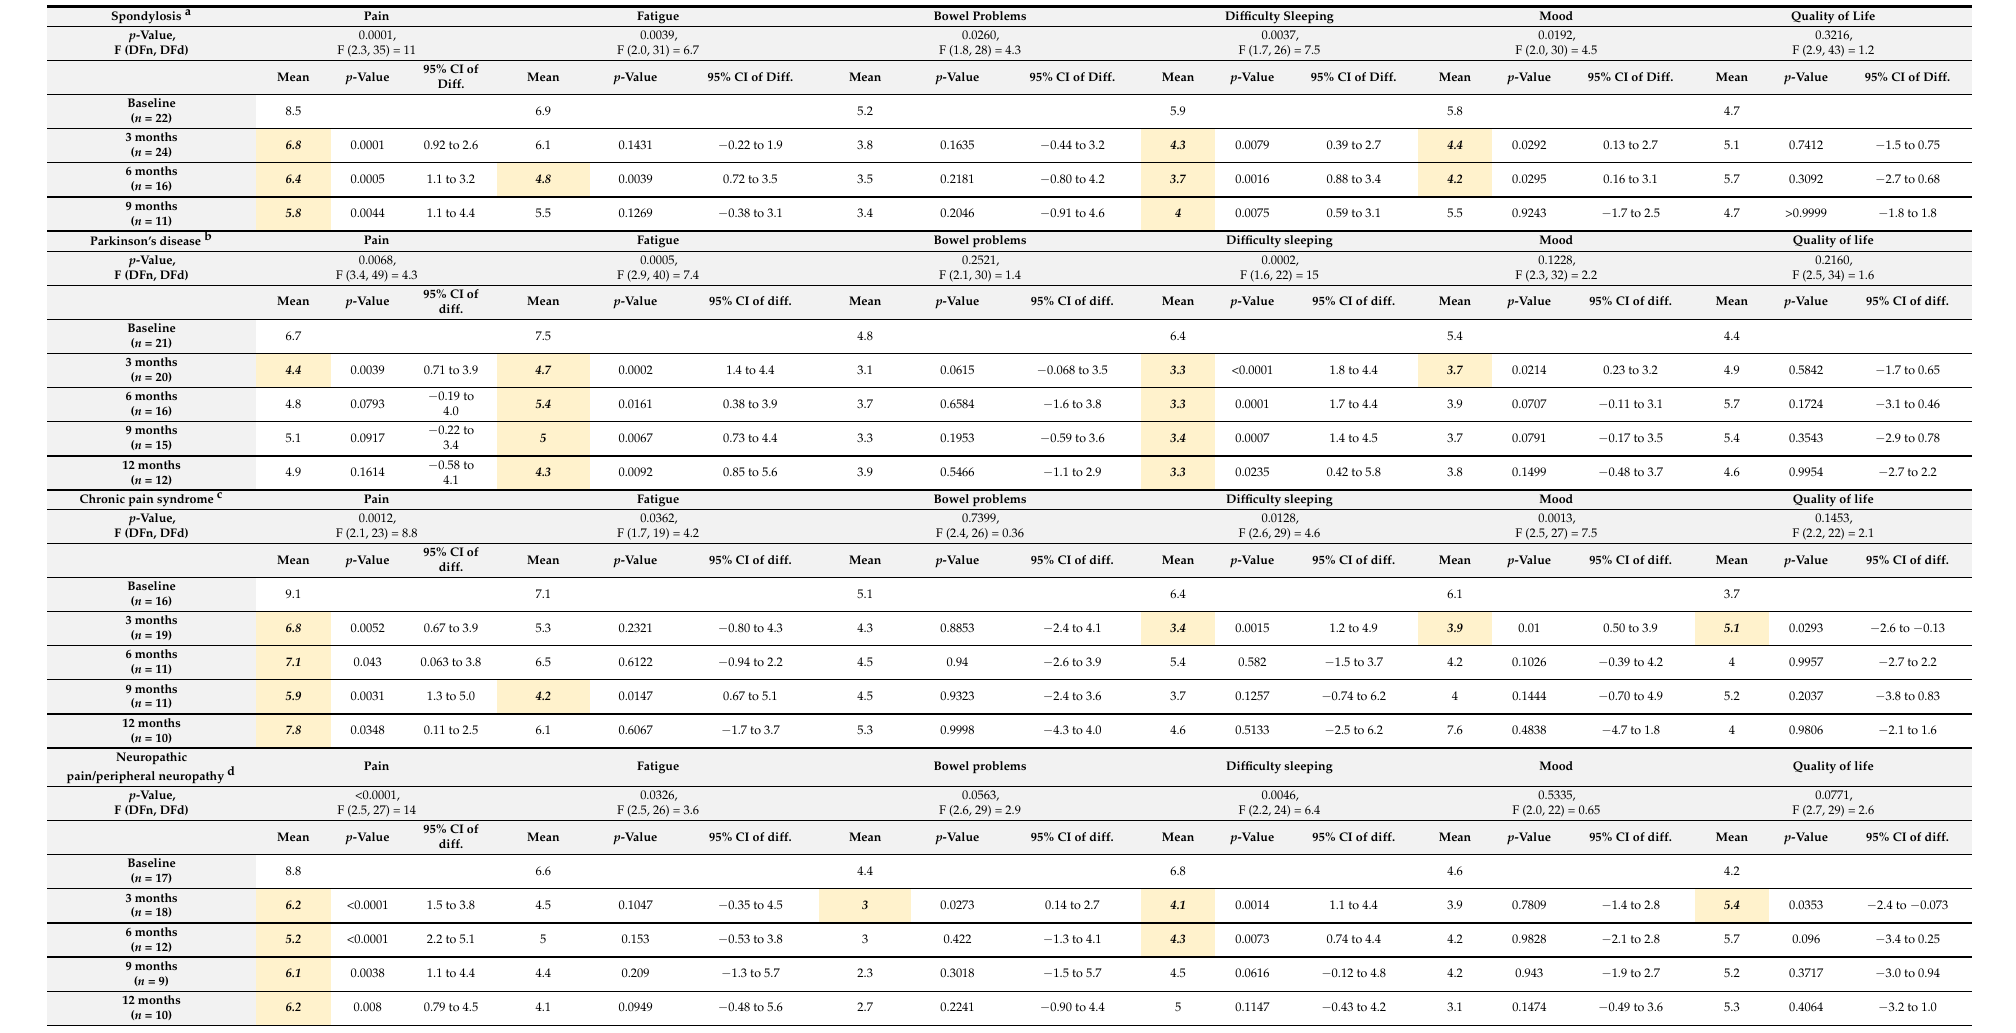
Table 3. Symptom assessment scale scores for patients with the condition: (a) spondylosis; (b) Parkinson’s disease; (c) chronic pain syndrome; (d) neuropathic pain and peripheral neuropathy; (e) migraine; (f) multiple